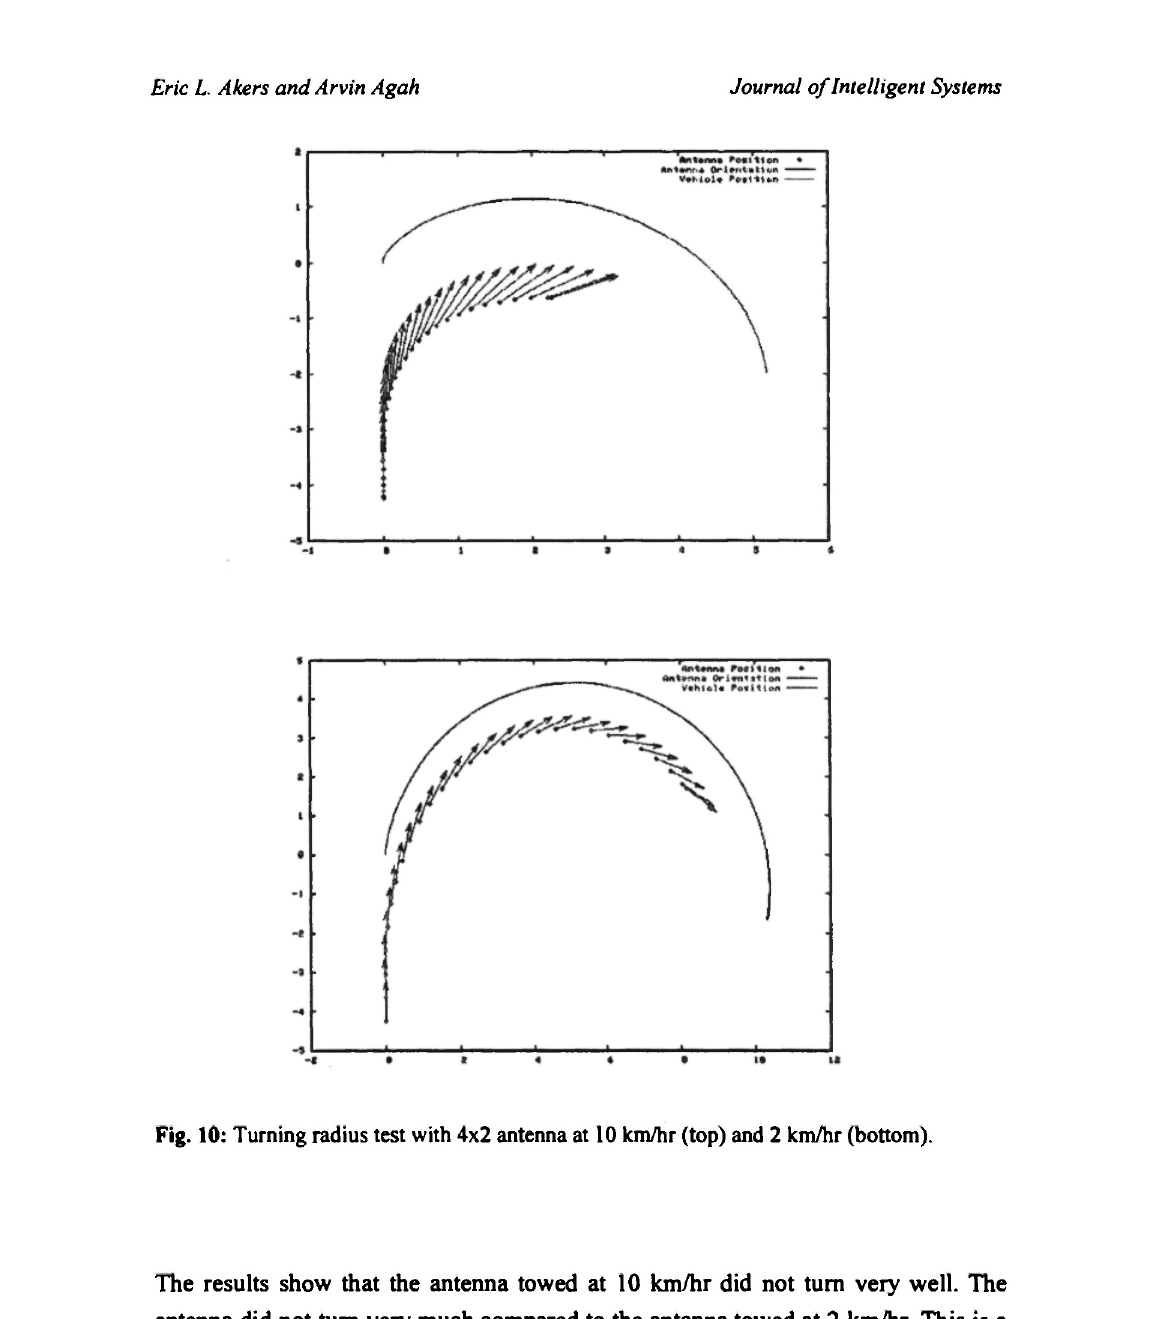
The results show that the antenna towed at 10 km/hr did not tum very well. The antenna did not turn very much compared to the antenna towed at 2 km/hr. This is a result of how the rover turns. With the rover turning so quickly, it has a tendency to tum in place. The rover moving at 2 km/hr required approximately twice the distance to tum around as the rover turning at 10 km/hr.